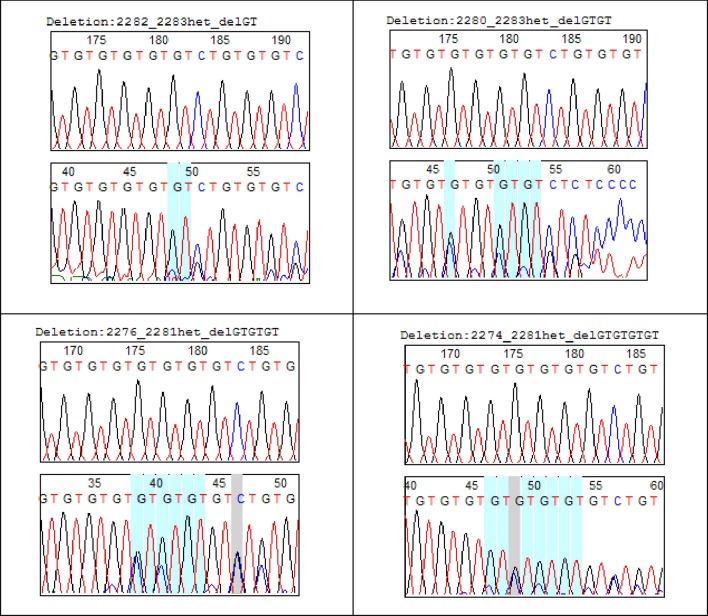
GTn
COLLA2 deletion in uterine fibroids.